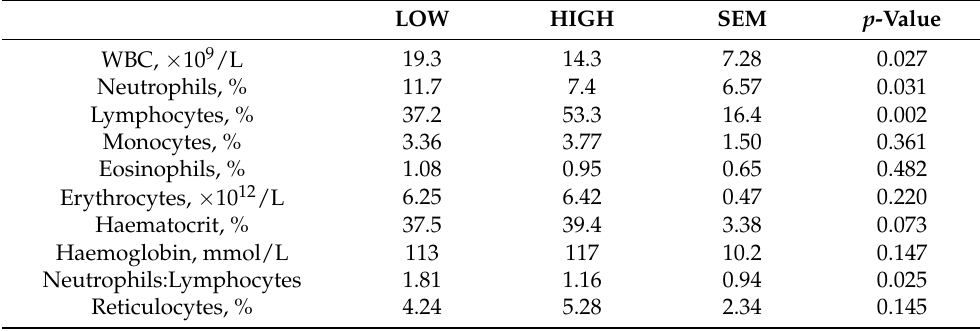
Table 4. Effect of maternal dietary antioxidant level on haematological parameters of the off-springs at day 25 of age (LOW: n = 26 piglets; HIGH: n = 27 piglets; Mean and standard error of mean